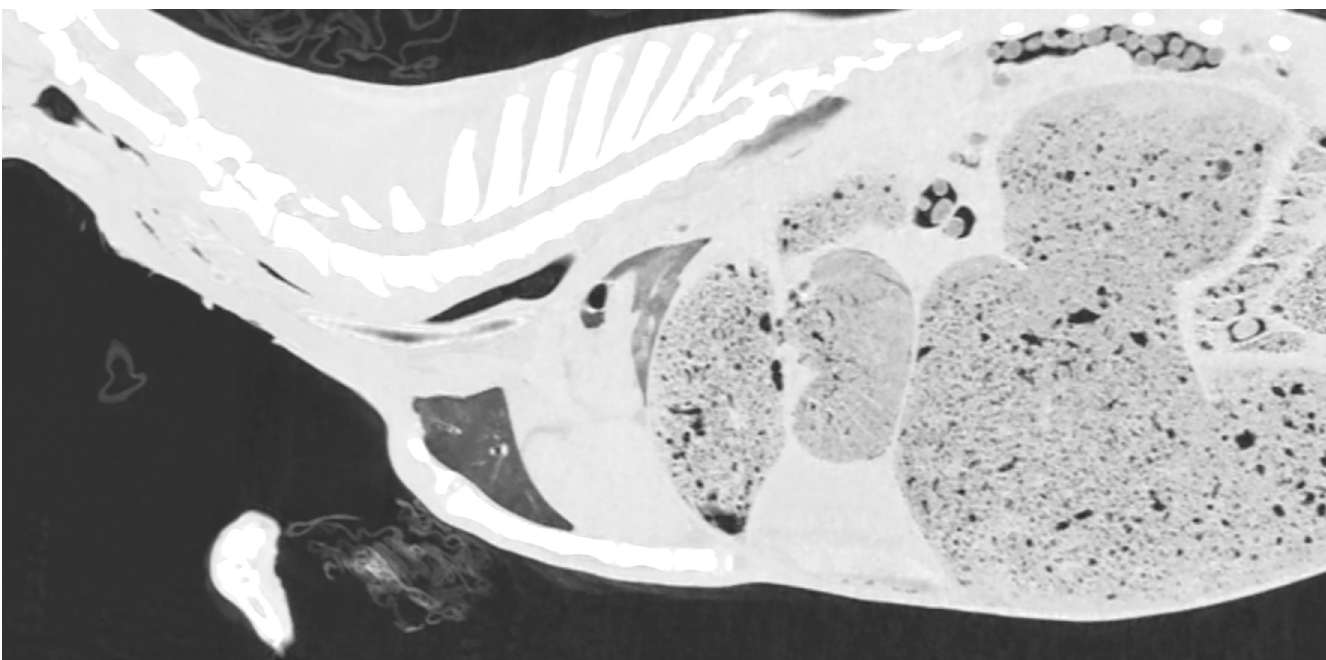
Fig 4. CT reconstruction in parasagittal plane before intra-arterial air inflation; lung window. Air visible only in the cervical and thoracic part of the esophagus and intestines.